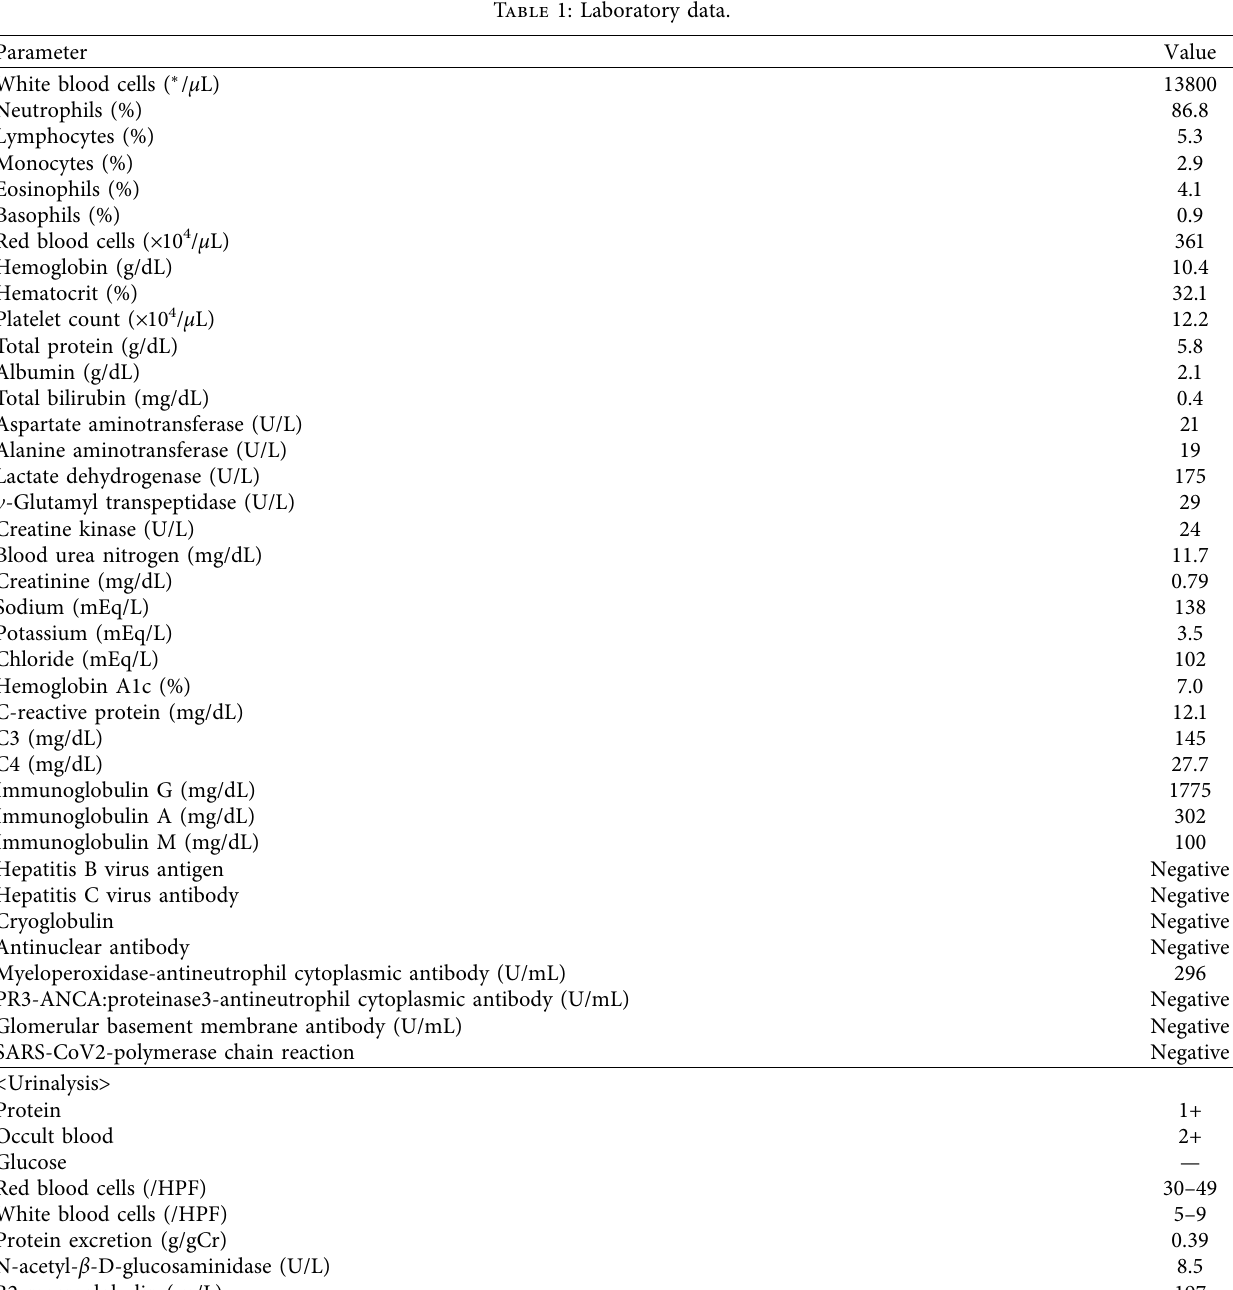
Table 1: Laboratory